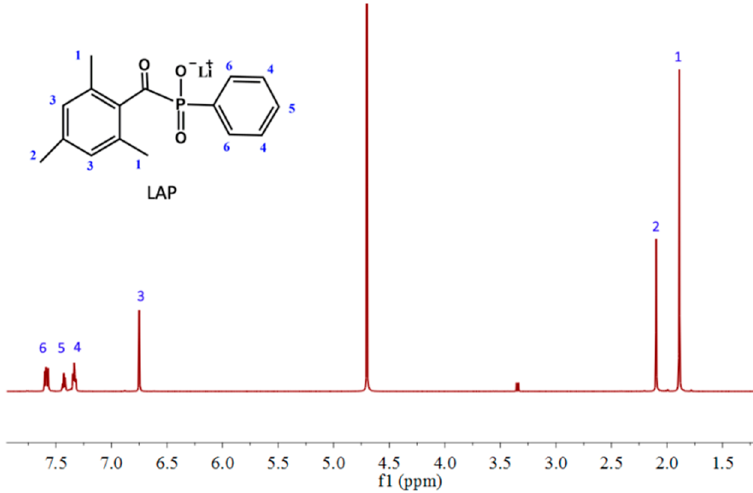
Figure 1. 1 H NMR spectra in D 2 O (400 MHz) of LAP showed that LAP had been successfully synthesized.